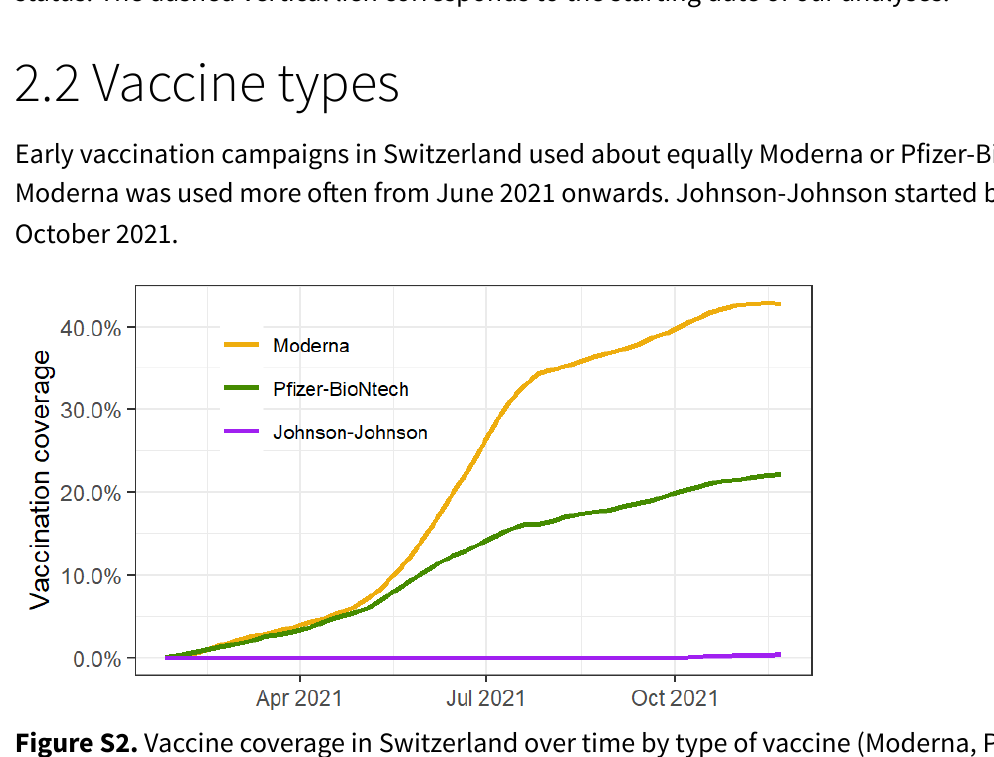
Figure S1. Proportion of hospitalizations and deaths with missing information about the vaccination status. The dashed vertical lien corresponds to the starting date of our analyses.